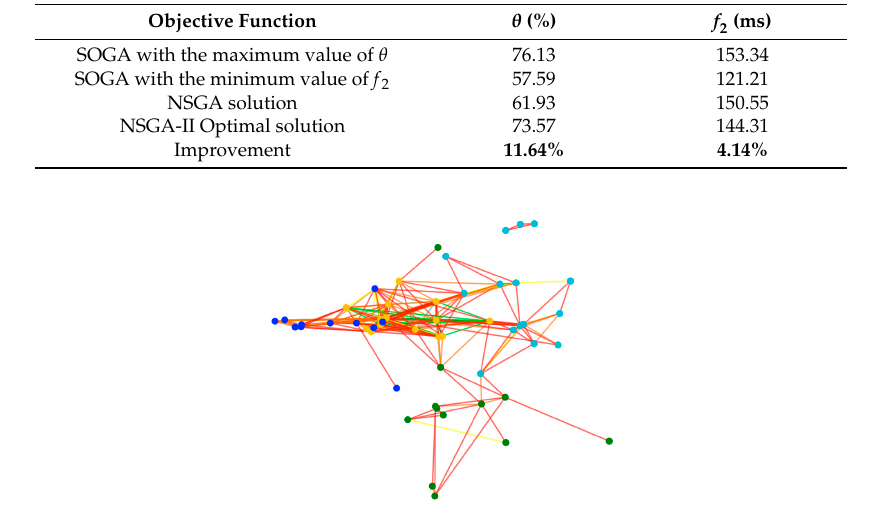
Figure 3. The results of the optimal solution.